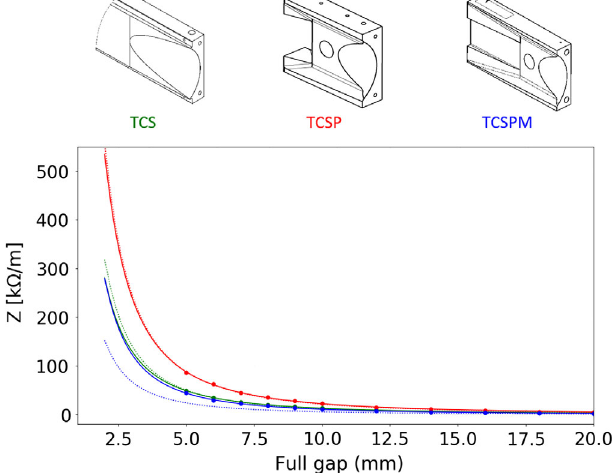
FIG. 16. Transverse impedance as a function of half-gap in mm from CST [59] simulations of the current TCSG taper (green dots), the TCSP taper (red dots), or the TCSPM taper (blue dots) compared to the flat taper theory [34] used for the model (black dashed line). Solid lines represent an extrapolation of simulation data toward small gap heights, where numerical simulation becomes computationally intensive. It is based on fitting of the simulation data with a Z ∝ 1 =g 2 , which is expected from the flat taper theory, assuming an unknown geometry-dependent numerical scaling